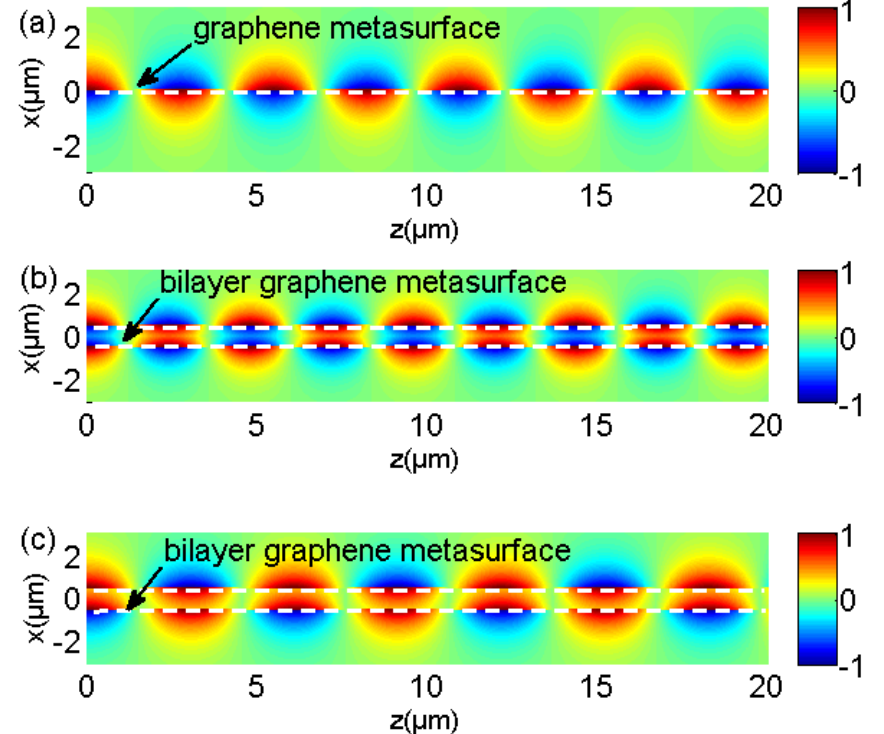
Figure 3. The electric field patterns of GSP mode on the ( a ) single- and ( b , c ) double-layer graphene metasurfaces at 2 THz as indicated in the inset of Figure 2. The white line denotes the location of each graphene metasurface.